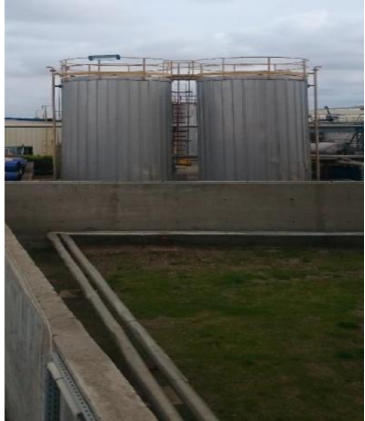
Figure 2. Bitumen reservoir studied in the factory.